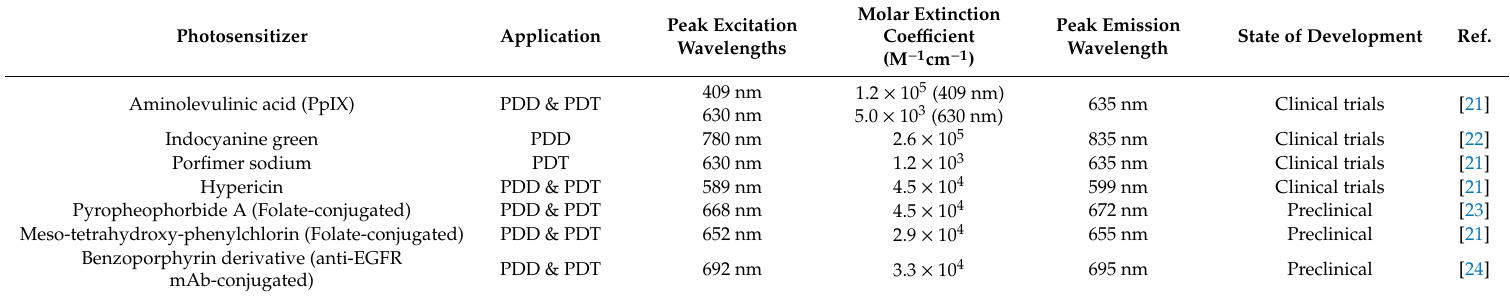
Table 1. An overview of clinically used and experimental photosensitizers for PDD and PDT of